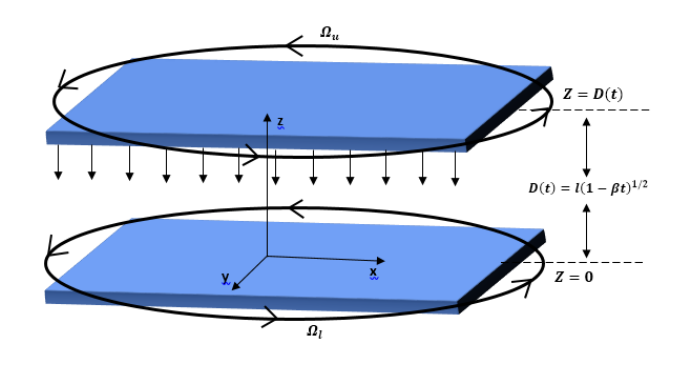
Figure 1. Geometry of the flow